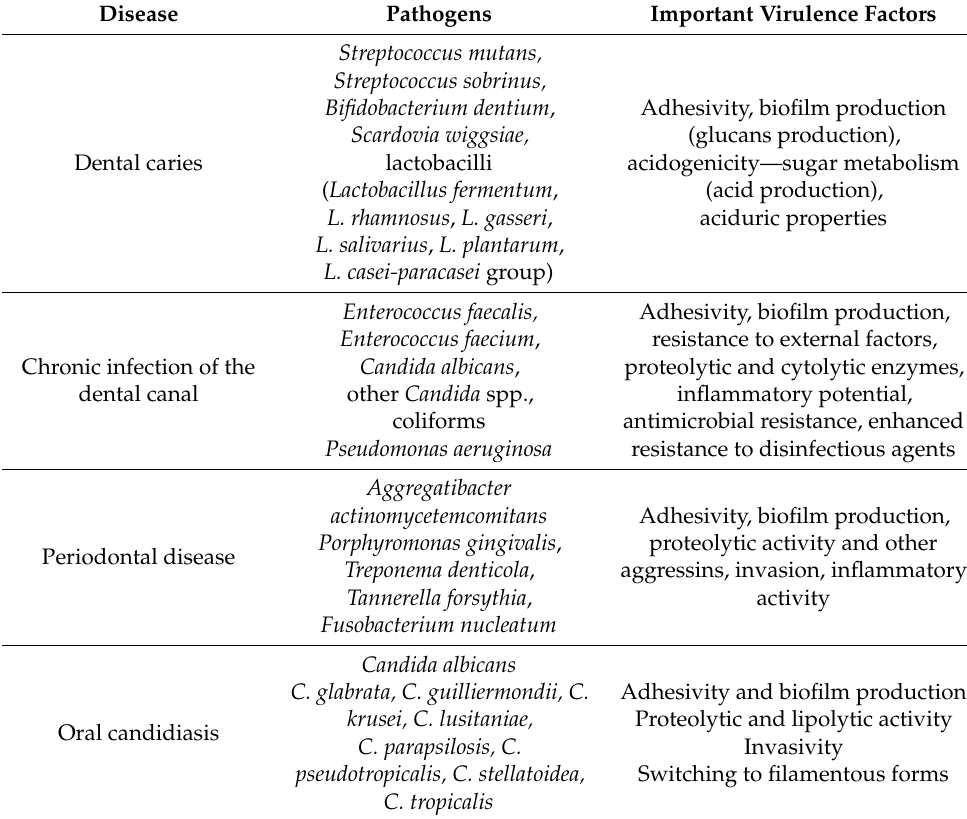
Table 2. The most important culturable oral pathogens